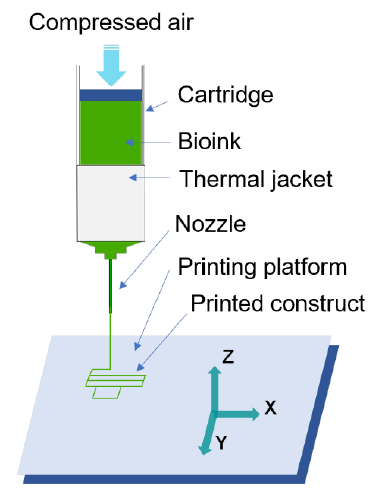
Figure 3. Illustration of extrusion-based bioprinting.